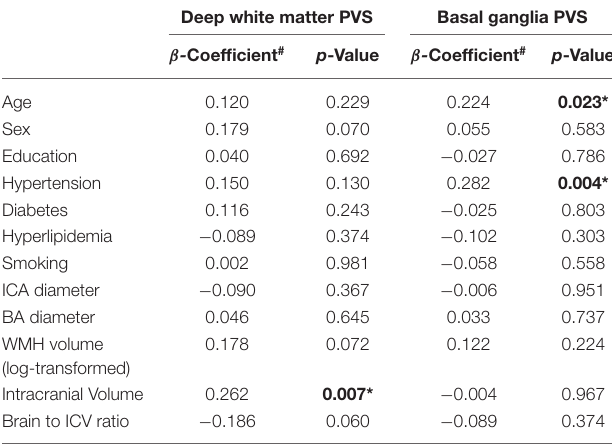
TABLE 2 | Results of simple linear regression